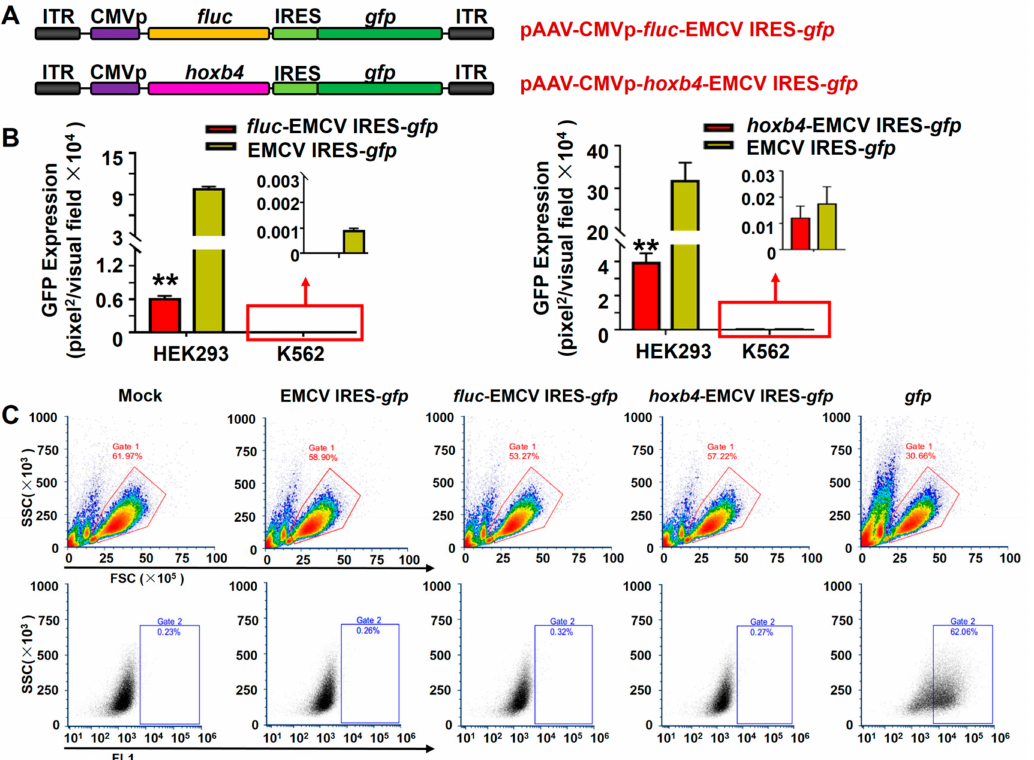
Figure 4. EMCV-IRES inhibited the expression of downstream transgene in hematopoietic cells. ( A ) Diagram of the rAAV6 vector genomes. ( B ) HEK293 cells and K562 cells were transduced with indicated rAAV6 vectors at 10,000 vgs / cell. Transgene expression was detected by fluorescence microscopy at 72 hours post-transduction. ( C ) Primary human CD34 + HSCs were transduced with indicated rAAV6 vectors at 10,000 vgs / cell. Transgene expression was detected by flow cytometry at 72 hours